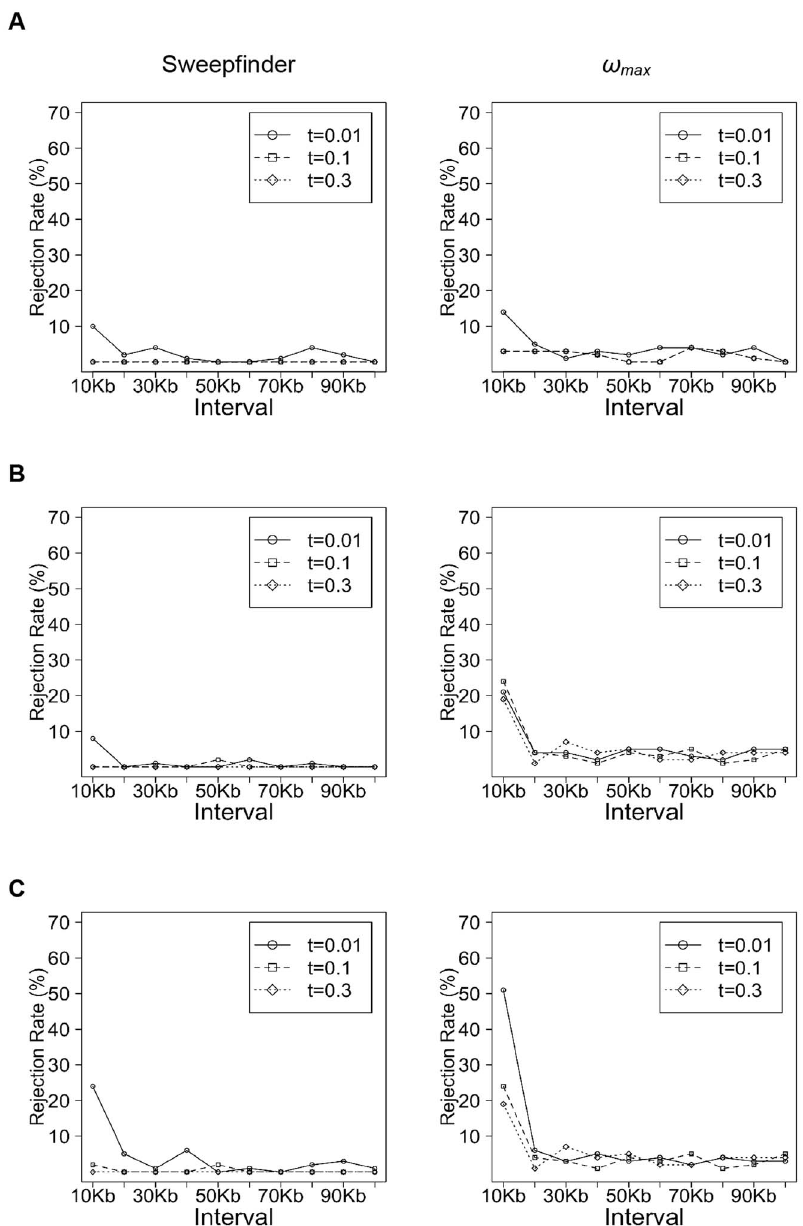
Figure 4. The fraction of simulated replicates rejecting neutrality by Sweepfinder and v max , varying the time since the beneficial fixation. Simulations with ancestral population size equal to (A) 10 4 , (B) 10 5 and (C) 10 6 . Selection strength ( s =0.01) and time since bottleneck ( t r =0.01) are fixed, but the time of selected allele fixation ( t ) varied from 0.01 to 0.3.